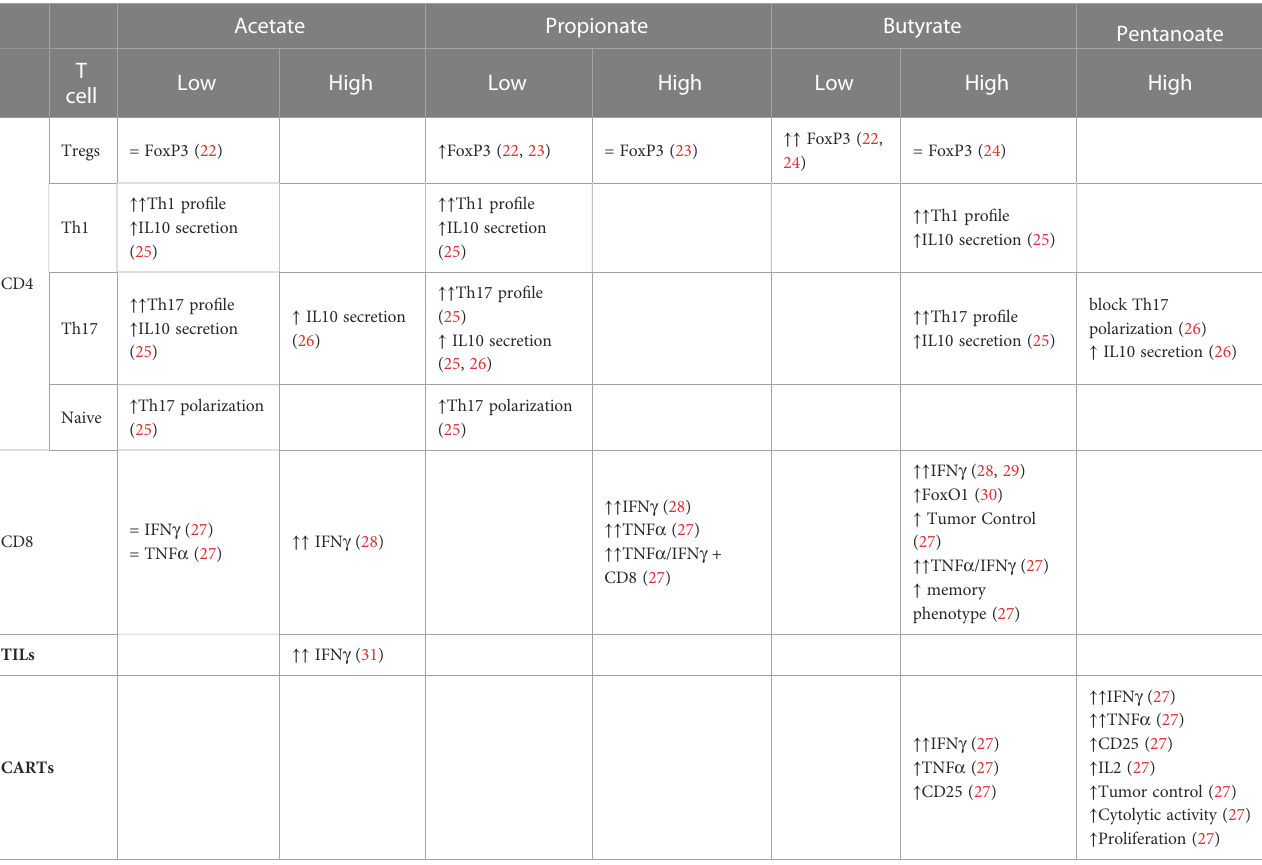
TABLE 1 ex vivo acetate, propionate, butyrate and pentanoate impact on diverse T cell subsets. Acetate Propionate